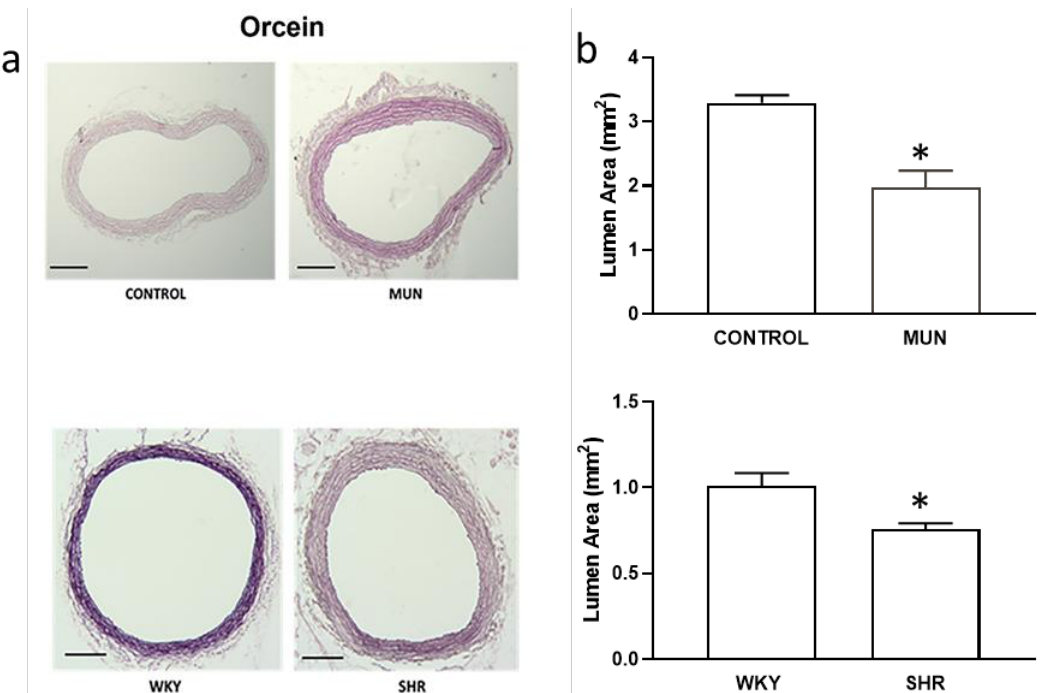
Figure 1. Histomorphometry of the lumen of mesenteric arteries from CONTROL and MUN (upper panel) and WKY and SHR rats (lower panel). ( a ) Images were obtained from orcein stained arteries (scale bar = 500 µm); ( b ) the graphics show the lumen area. MUN, offspring exposed to maternal undernutrition during pregnancy; CONTROL, offspring from mothers fed ad libitum during preg- nancy; SHR, spontaneously hypertensive rats; WKY, Wistar Kyoto rats. Values are mean ± s.e.m. from 6 rats of each group. Significant differences from the respective control rat: * p < 0.05.